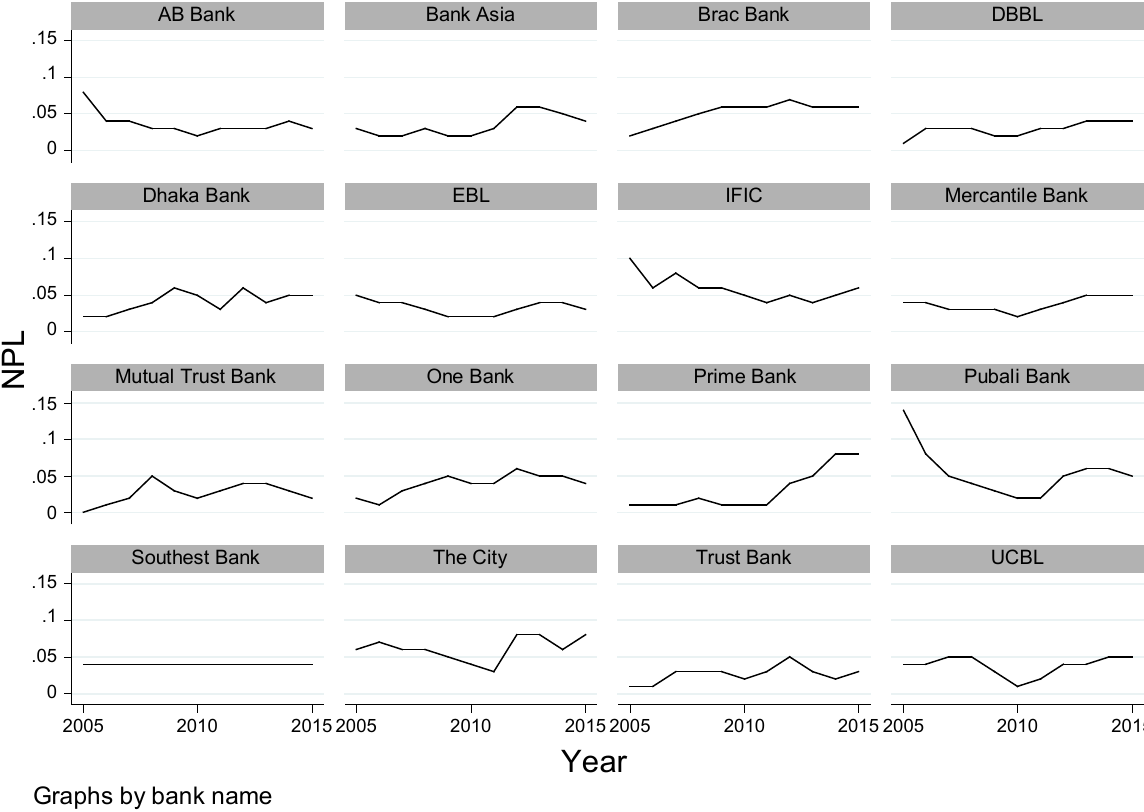
Figure 12. Comparison of the nonperforming loans from the period 2005 to